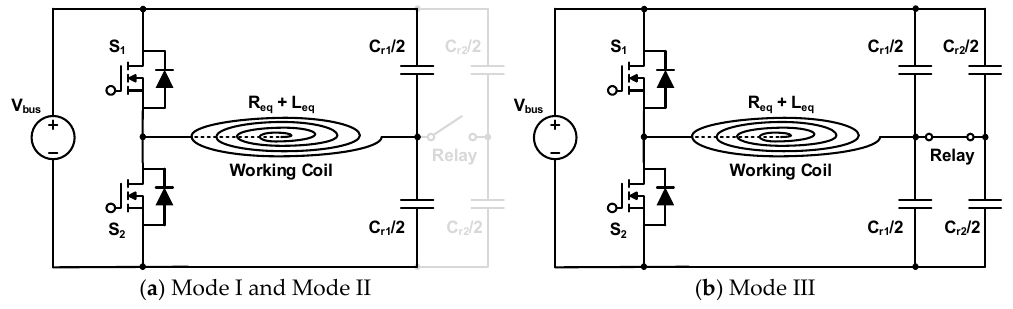
Figure 6. Operating modes of the proposed all-metal IH system.